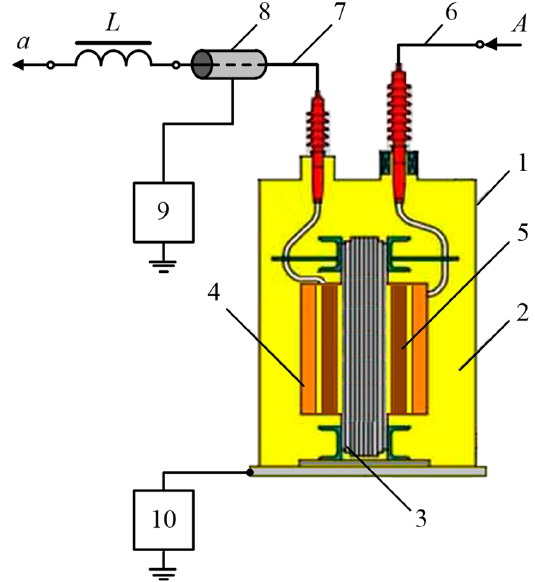
Figure 2. General flowchart of the transformer components’ parameters monitoring system.